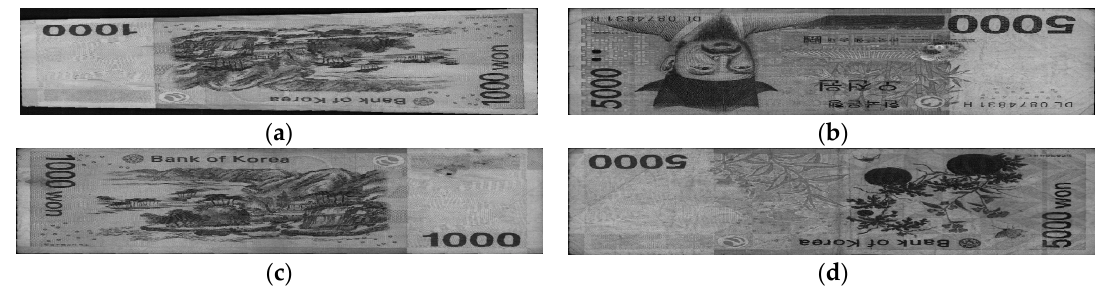
Figure 10. Examples of false recognition cases by our method in the KRW dataset: ( a ) fit banknote misclassified to normal; ( b ) normal banknote misclassified to fit; ( c ) unfit banknote falsely recognized